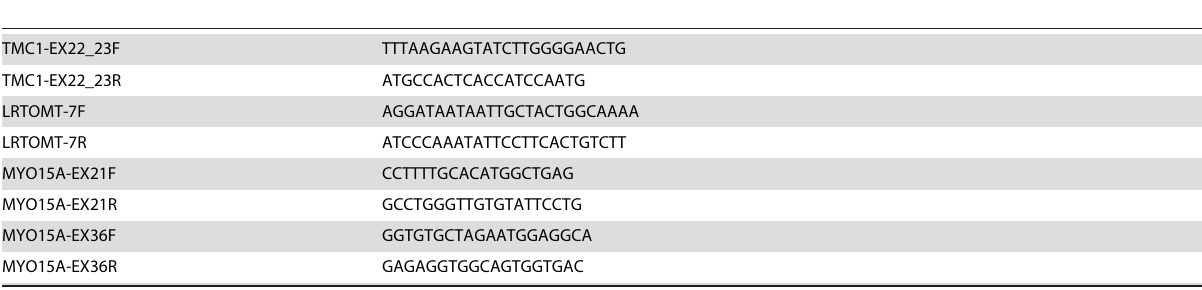
Table 1. Sequences of the primers used to validate the mutations by Sanger